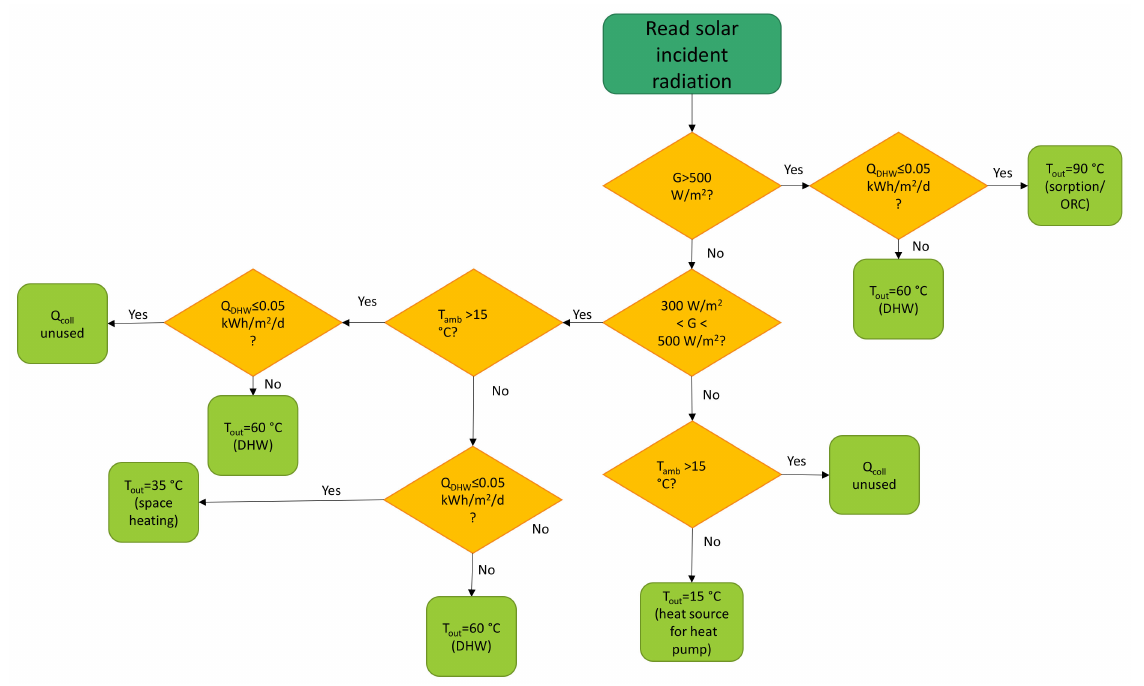
Figure A3. Control of the outlet temperature from the solar